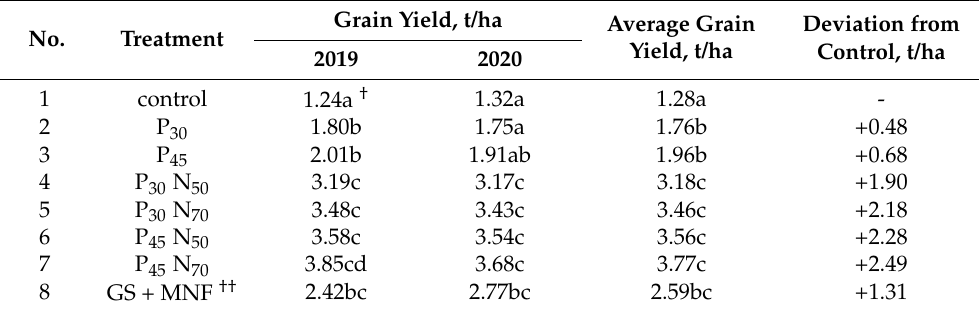
Table 6. Grain yield of rainfed winter wheat at direct sowing as affected by doses of mineral fertilization in South Kazakhstan (average for four field